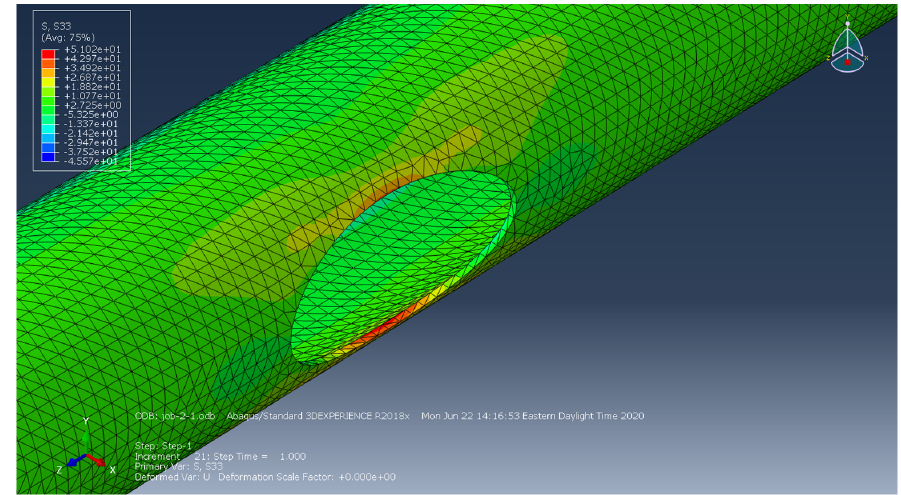
Figure 11. Aspect ratio 2-1 in longitudinal (Z) direction.